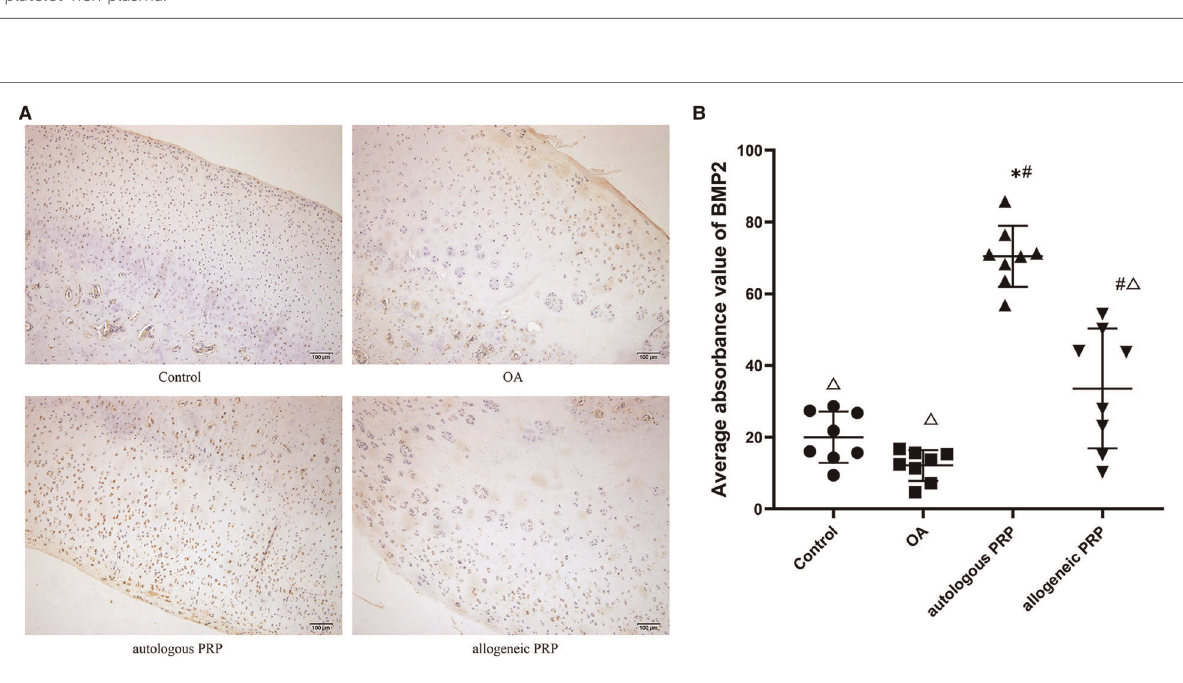
the model group had the lowest BMP-2 expression (mean; standard deviation: 12.09; 4.25) in each group. The number of positive cells and expression intensity in the autologous P- PRP group were signi fi cantly higher than those in the normal